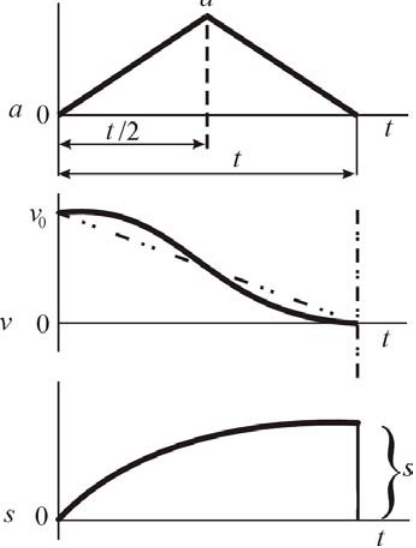
Fig 6. Rate of deceleration with a symmetrical triangular form In Fig 6 a, computational dimensions are noted as: